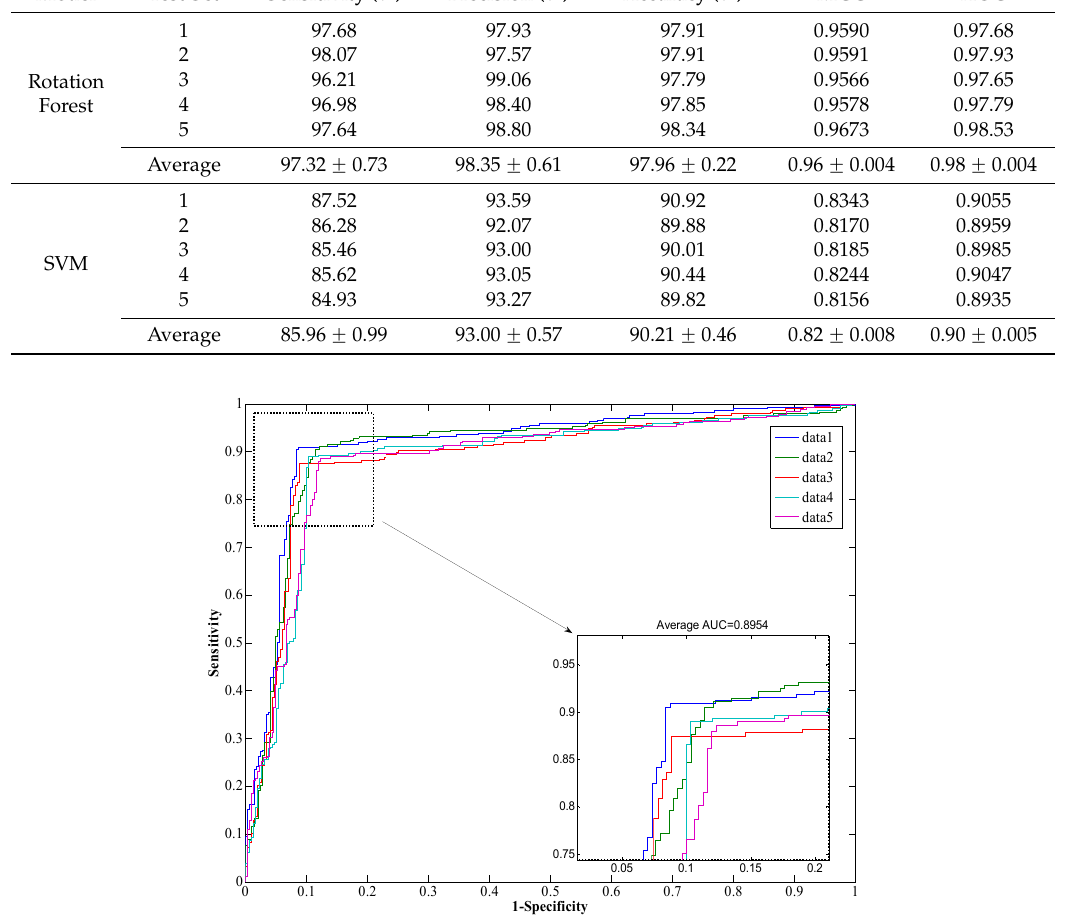
Table 3. The prediction results of the Human dataset using the proposed method compared with SVM. Model Test Set Sensitivity (%) Precision (%) Accuracy (%) MCC AUC Rotation Forest